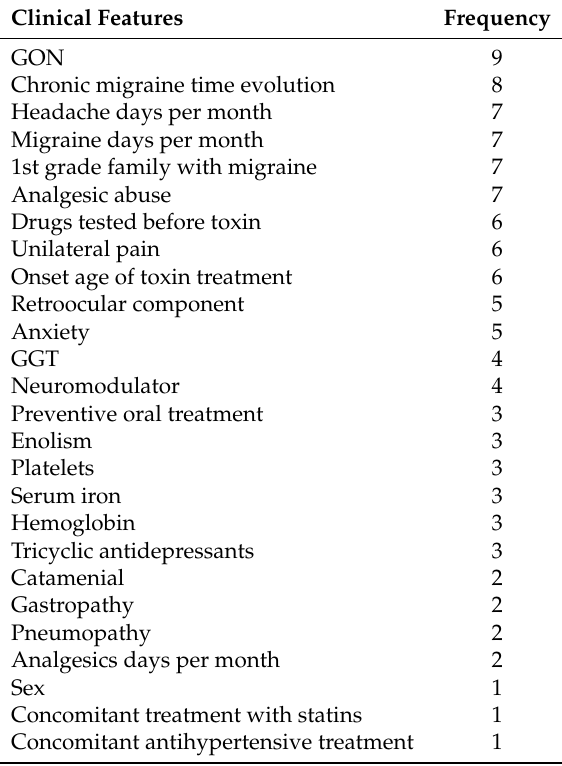
Table 7. Frequency of selected clinical features by the SOFIA method in the nine metaheuristic methods of Table